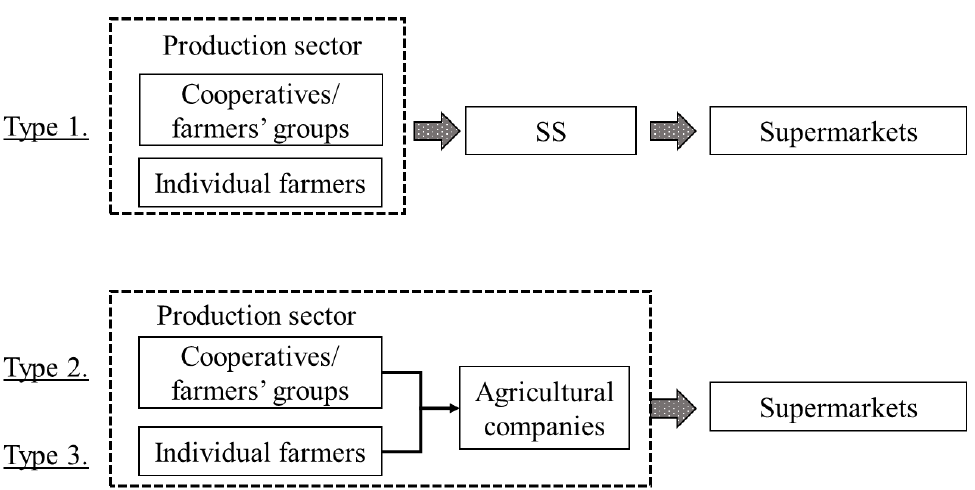
Figure 2. Main channels of rural suppliers for supermarkets in West Java described in detail by the World Bank [25].